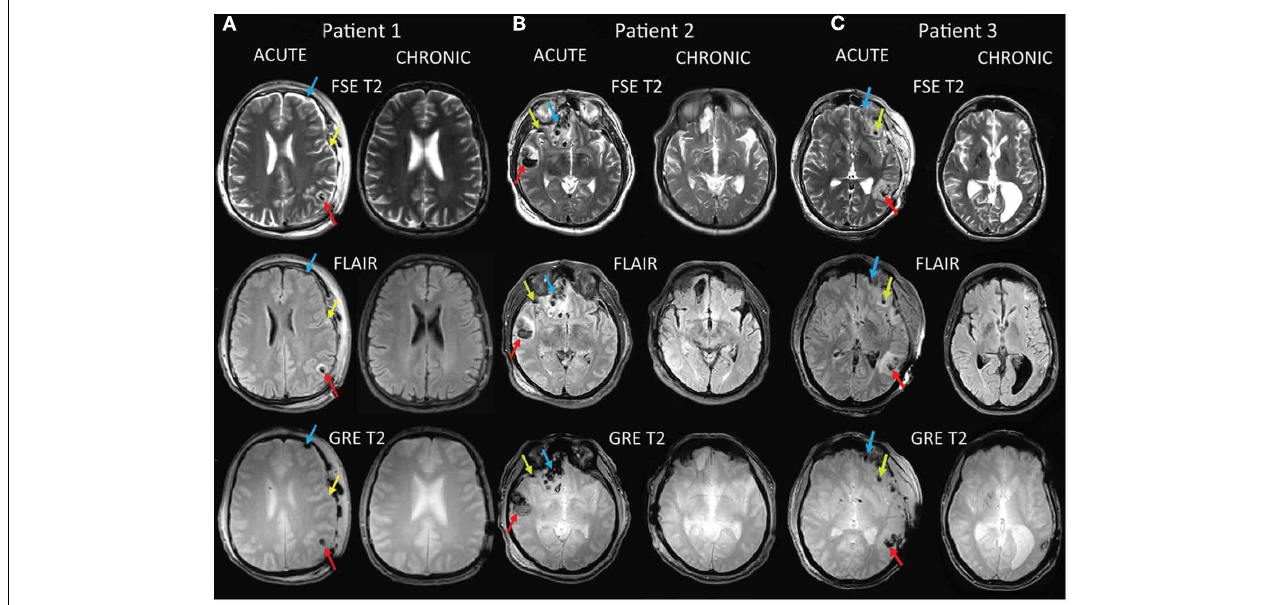
FIGURE 1 | Sample MR images for threeTBI cases labeled as patient 1 (A), patient 2 (B), and patient 3 (C). Images are displayed in radiological